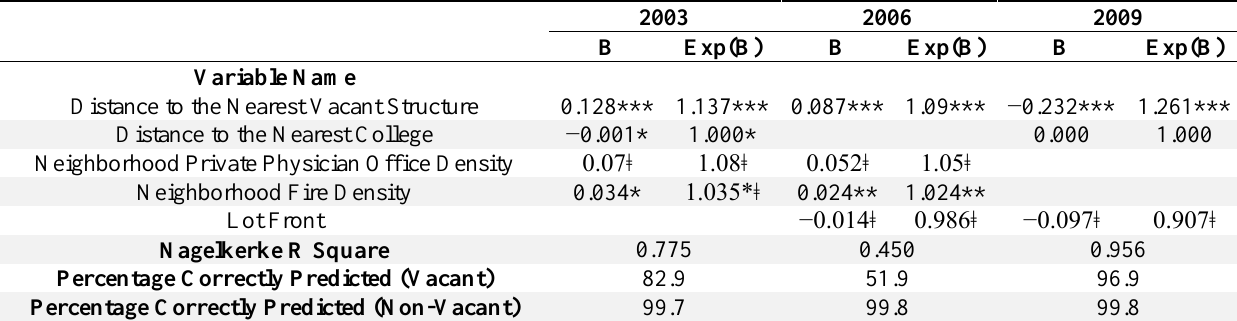
Table 5. Binary logistic regression model on